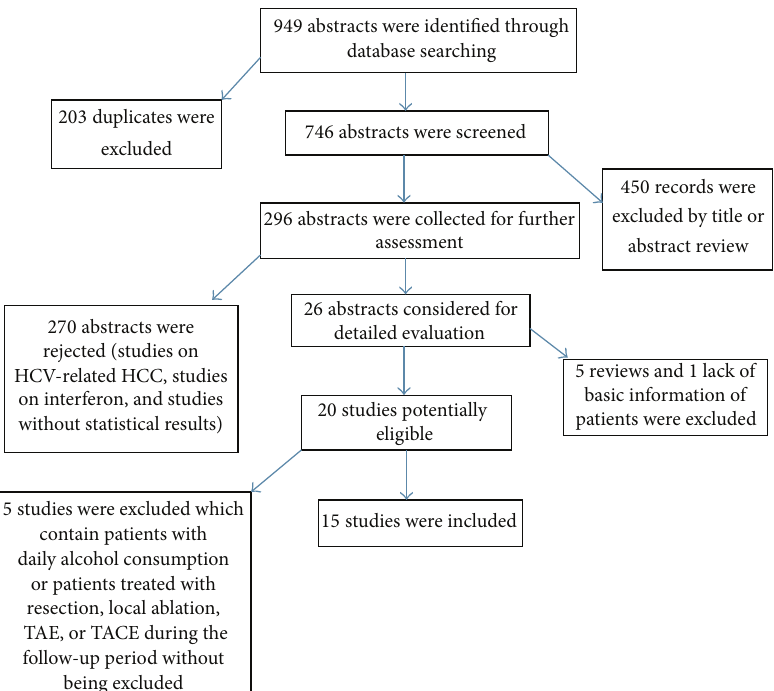
Figure 1: Flow chart depicting the study selection process: 15 studies were included in this